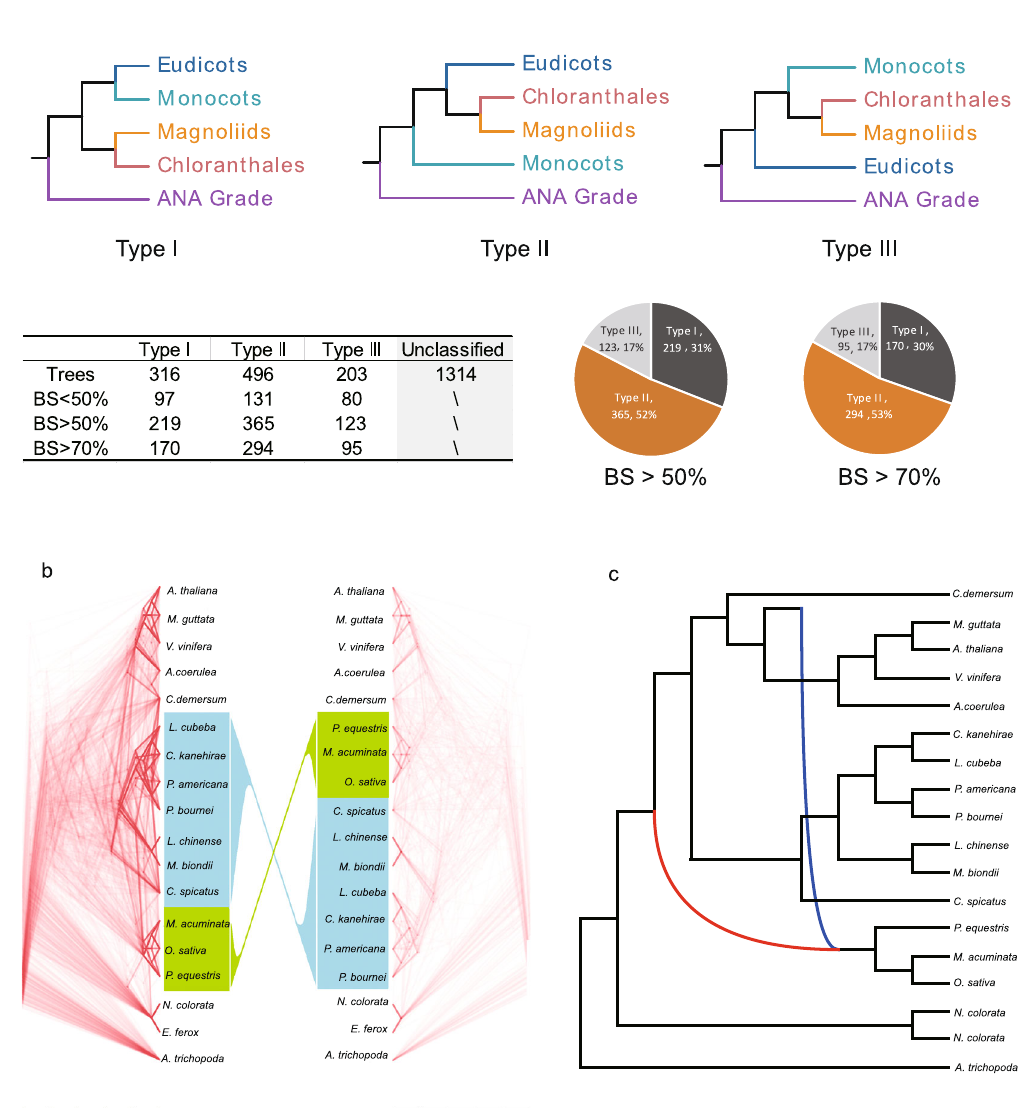
Fig. 3 Gene tree discordances among the fi ve major groups of Mesangiospermae . a A summary of the con fl icts among gene trees in the 2,329-LCN data set with regard to the proportions of trees supporting three different branching patterns for Chloranthales-magnoliids, monocots, and eudicots. b Gene tree incongruence between nuclear (2,329 LCN genes) and plastid (80 plastid genes) trees in a consensus DensiTree plot. c A consensus scenario showing ancient gene fl ow between monocots and eudicots, inferred by QuIBL, PhyloNet, and ABBA-BABA D-statistics. Source data underlying Fig. 3b are provided as a Source Data fi